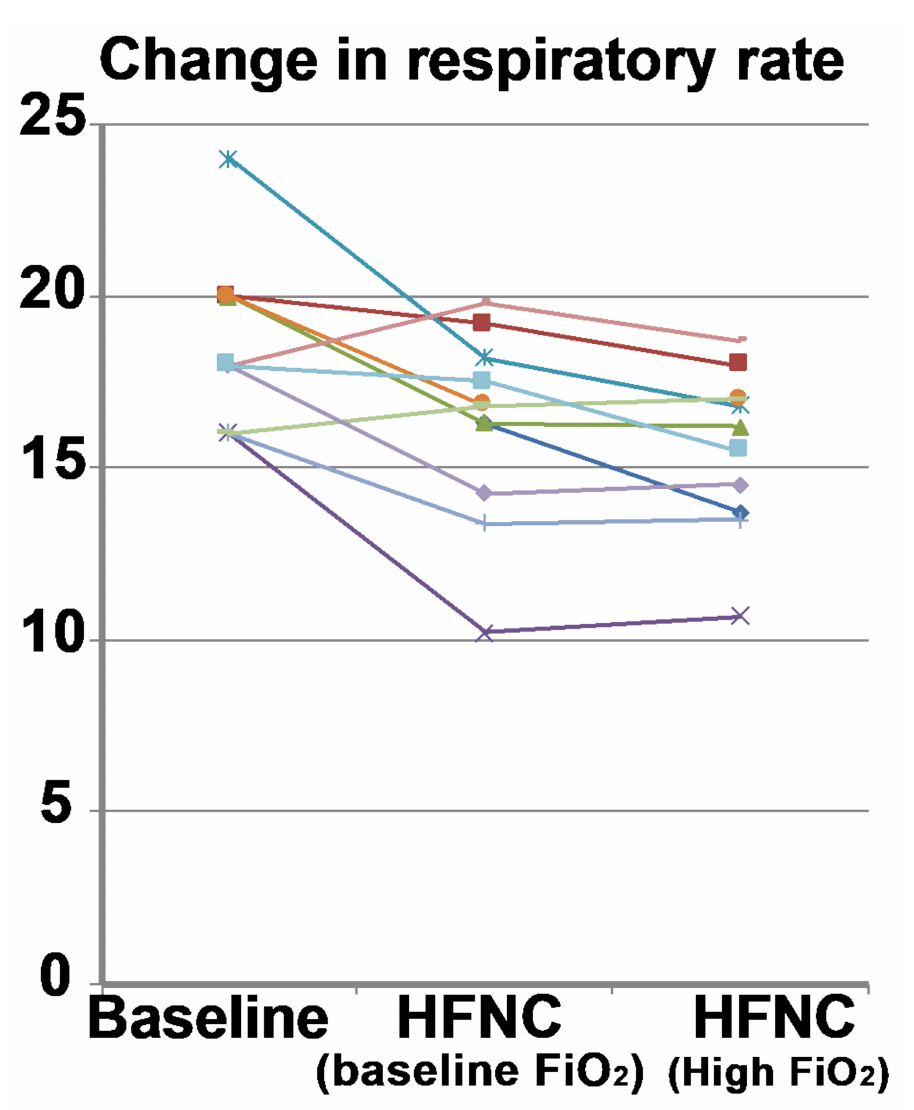
Figure 5. Baseline respiratory rate (respiratory rate) compared to high flow nasal cannula at baseline FiO 2 and increased FiO 2 . The respiratory rate decreased in most subjects ( n = 10; 90.9%) when HFNC was applied at baseline and at increased FiO 2 . Each colored line represents the individual response of the